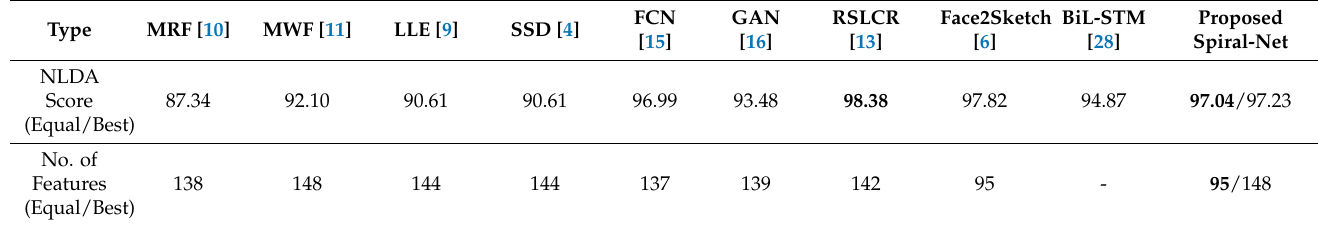
Table 5. Comparison of face recognition scores for